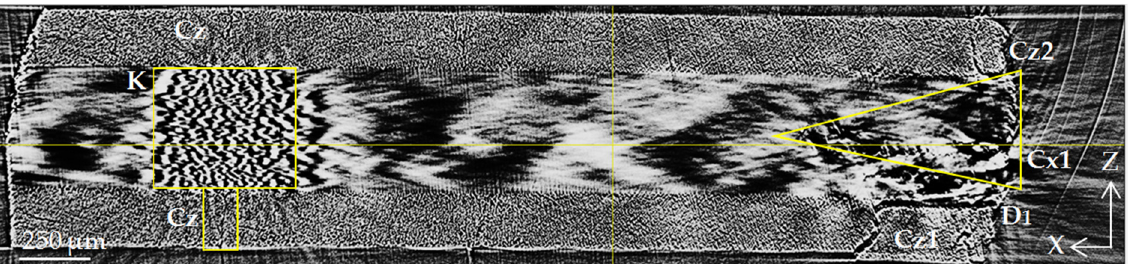
Figure 8. Transverse XY slice of the loaded CFRP sample (slice position is marked in Figures 6 and 7). D1 is interlayer delamination; Cx—transverse crack spreading along the X-axis (90° fibers); Cz—vertical cracks along the Z-axis (0° fibers); K—kinking of fibers. Planes ZY1 and ZY2 marked by lines in Figures 6 are presented in Figure 9.